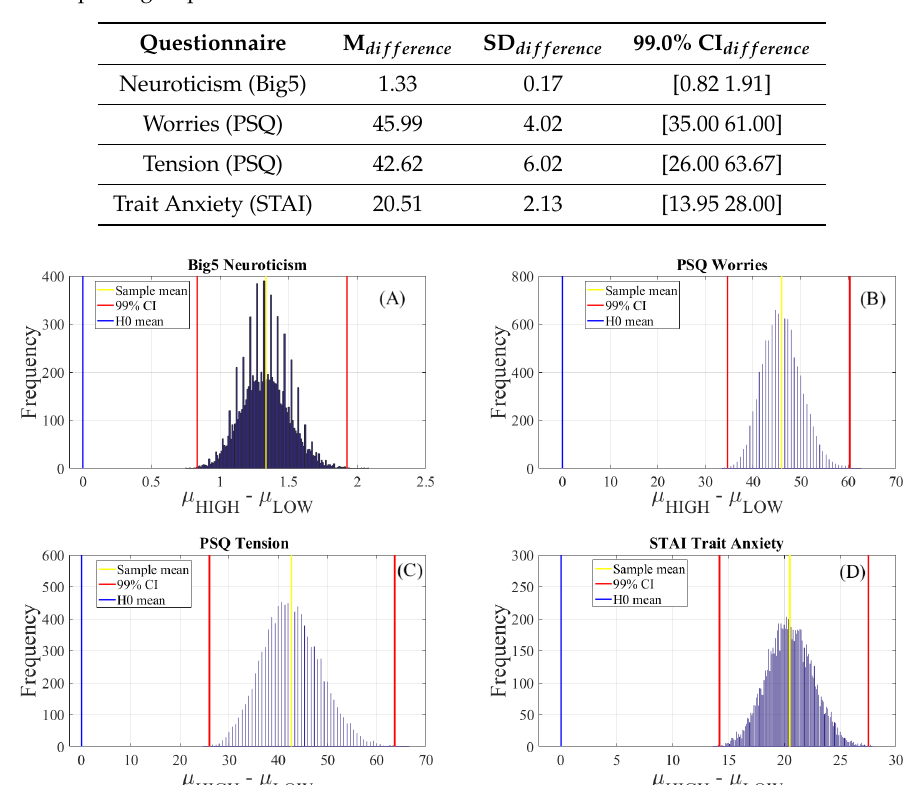
Table A11. Results associated with paired two-sample bootstrap test of significance (10,000 simulation runs) at 99.0% ( p < 0.01) confidence interval (CI) associated with responses of participants in HIGH versus LOW stress-susceptibility to questionnaires. M and SD refer to the mean difference and the standard deviation of such a difference between participants’ responses in HIGH versus LOW stress-susceptible groups. CI shows the 95% confidence interval of these differences.